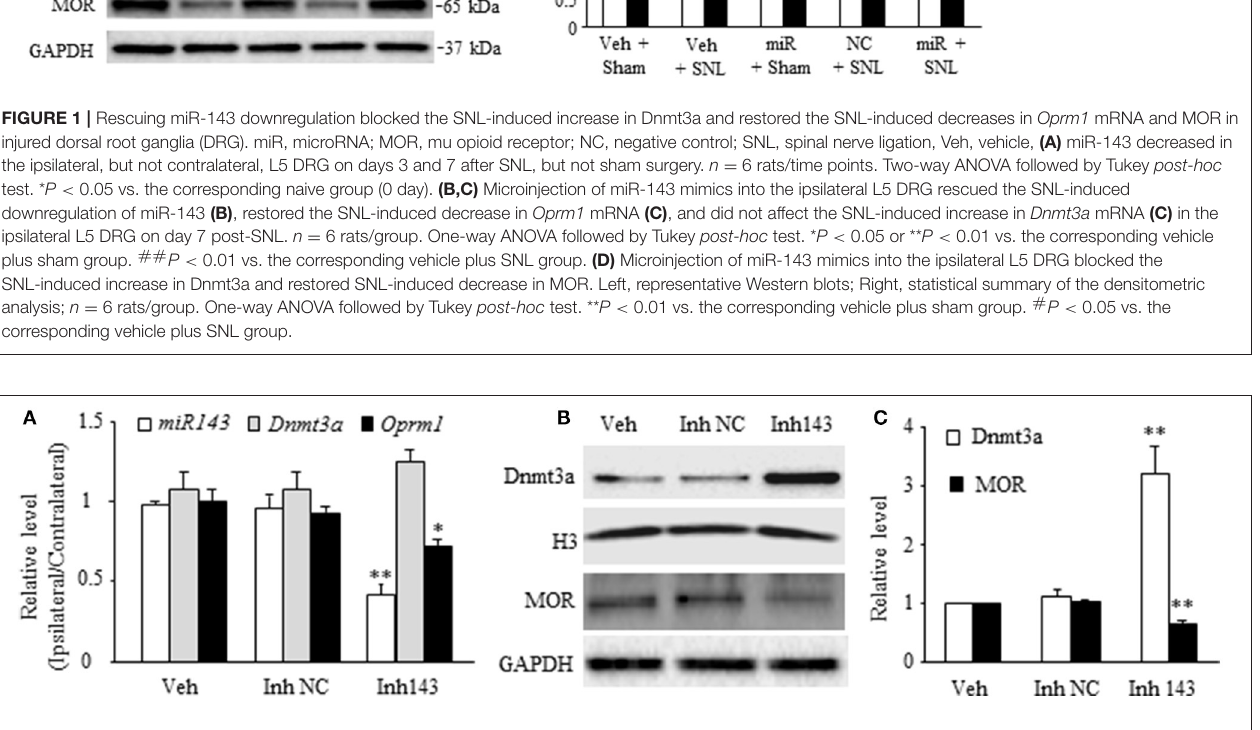
FIGURE 2 | miR-143 knockdown caused by DRG microinjection of miR143 inhibitors increased the expression of Dnmt3a and reduced the expression of Oprm1 mRNA and MOR in the injected DRG of naive rats. Inh143, miR-143 inhibitors; Inh NC, inhibitor negative control; Veh, vehicle. (A) Microinjection of miR-143 inhibitors, but not their negative control, into unilateral L4/5 DRGs reduced the expression of miR-143 and Oprm1 mRNA and had no effect on relative expression of Dnmt3a mRNA. n = 3 6 rats/group. One-way ANOVA followed by Tukey post-hoc test. * P < 0.05 or ** P < 0.01 vs. the corresponding vehicle group. (B,C) Microinjection of miR-143 inhibitors, but not their negative control, into unilateral L4/5 DRGs increased the expression of Dnmt3a and reduced the expression of MOR in the injected DRG. (B) representative Western blots. (C) statistical summary of the densitometric analysis. n = 6 rats/group. One-way ANOVA followed by Tukey post-hoc test. ** P < 0.01 vs. the corresponding vehicle